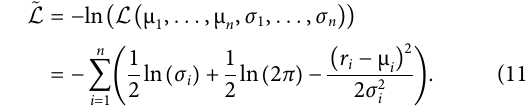
Pearson correlation coef fi cient (PCC) of estimated σ 2 , along with its statistical signi fi cance, squared returns r 2 t Figure 5 . However, for a more precise statistical quanti fi cation of the difference between models and their GARCHX variants, more advanced statistical tests are needed. For that purpose, we employ predictive negative log-likelihood (NLLH) [47].